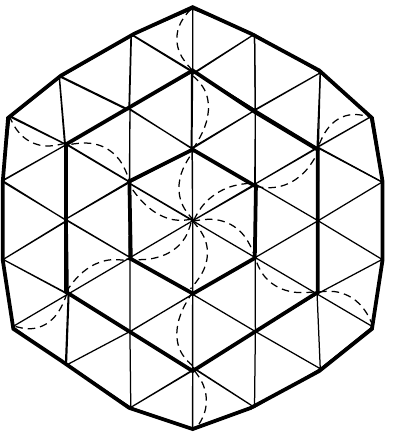
Figure 3.1. Adding edges (dashed) to (cid:2) 3 produces an augmented graph (cid:2) ∗ 3 . Vertices on the same layer are indicated by the darker